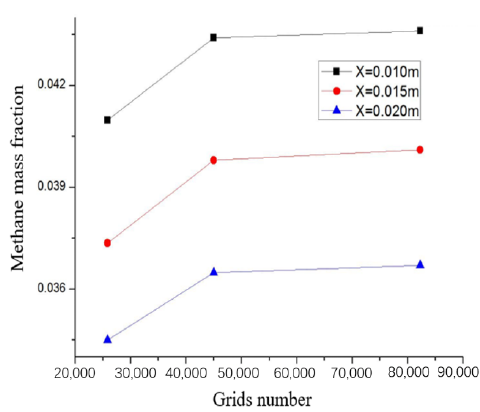
Figure 2. Grid independence verification.